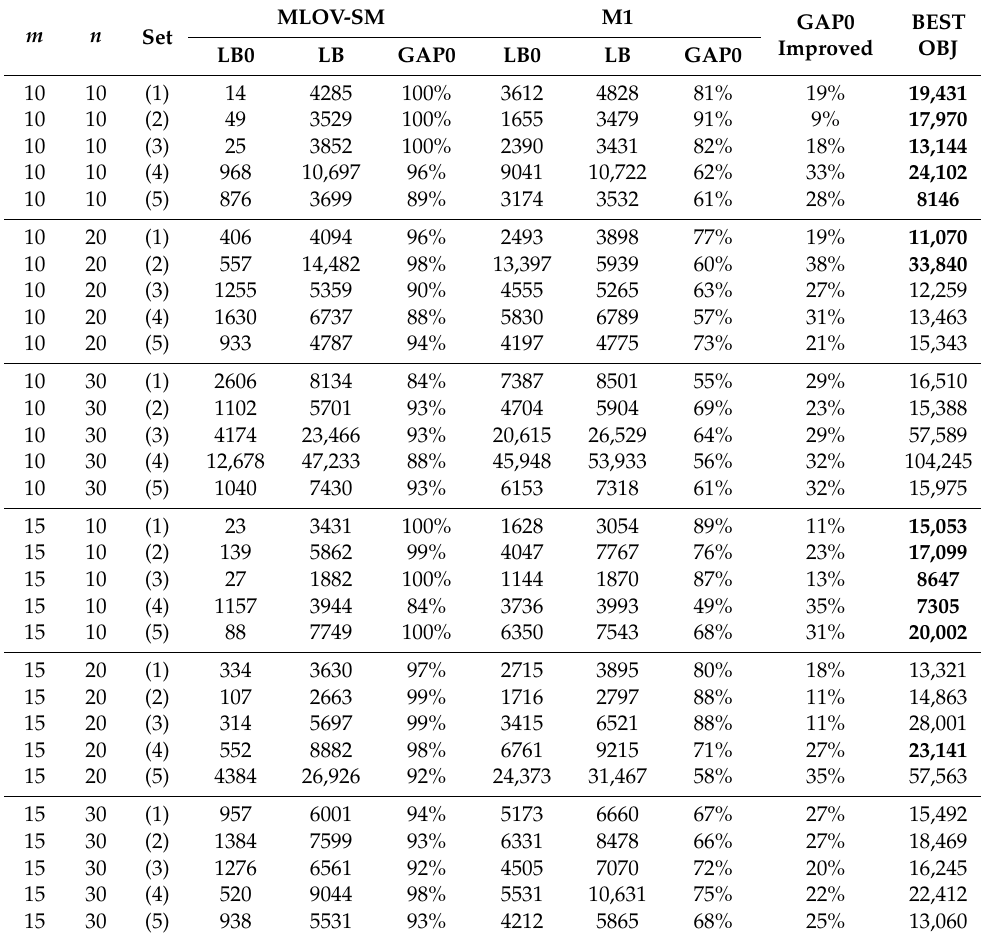
Table 2. The objective values of linear programming (LP)-relaxation of analysis of performance of (M1) and setup-splitting model